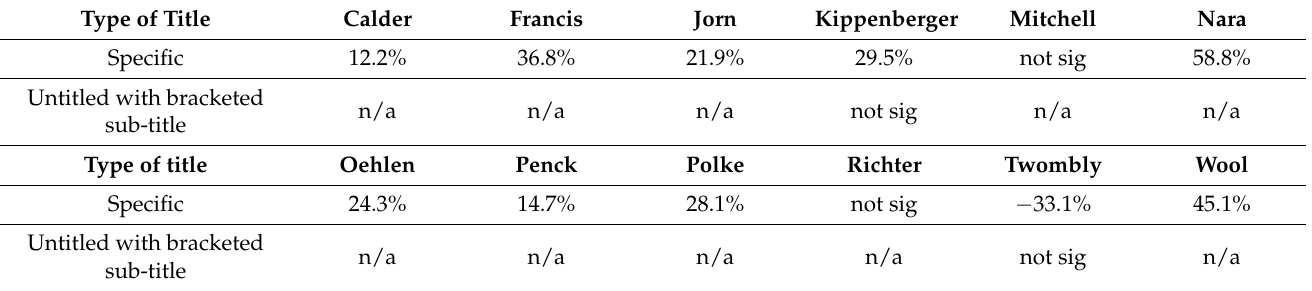
Table 3. Percentage change in price for works with specific titles or presented as untitled with a sub-title in brackets, compared to generic